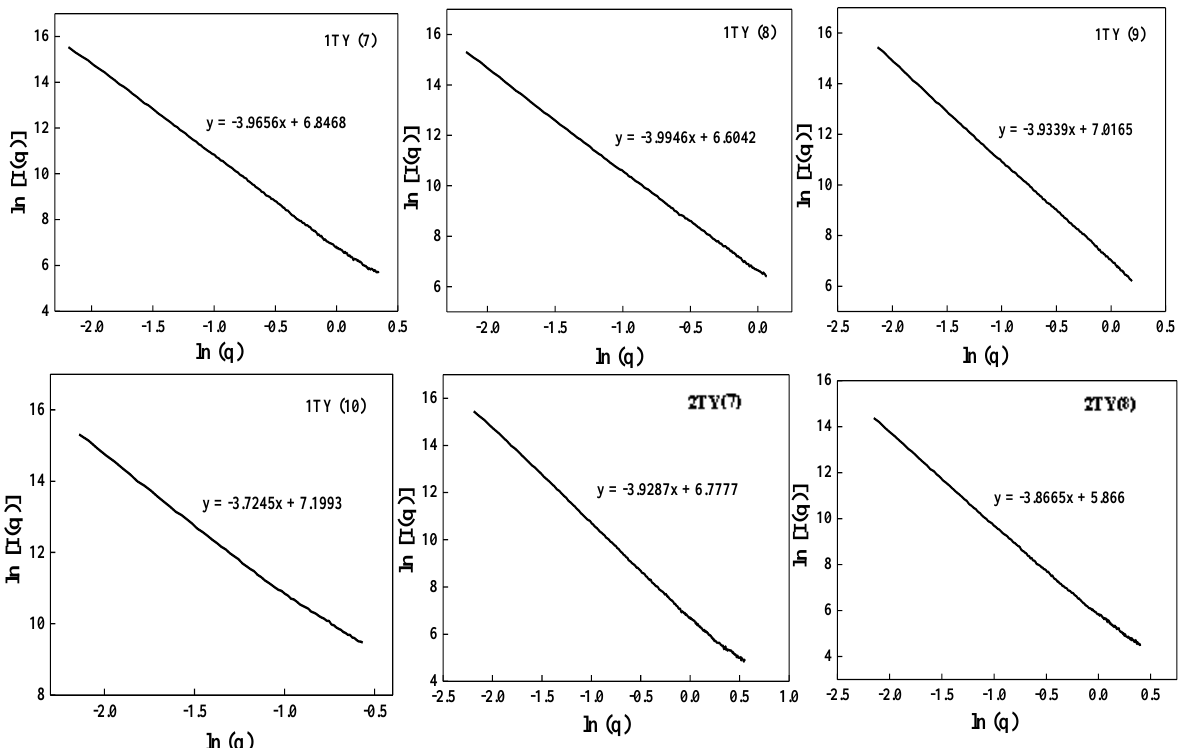
Figure 5. Graphical representation of scattering data from which the scattering exponent ( α = slope) was estimated in the case of Ti-zeolite Y samples using linear regression. The best-fit equation is depicted for each data set.